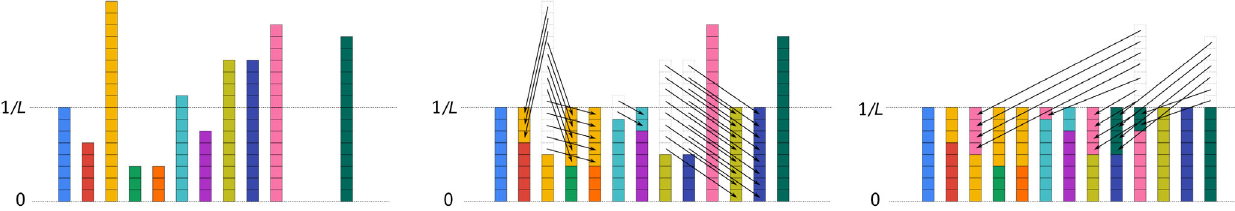
FIG. 13. Depiction of choosing alt l and keep l values for a discretized probability distribution. The left histogram is the input probability distribution, after discretization into steps of 1 = ð 2 3 L Þ . The squares must be redistributed so that every column has at most two colors and height of 1 =L (i.e., eight squares as indicated by the dashed line) without moving the bottom square of each column. The histogram on the right satisfies these constraints, and the histogram in the middle is an intermediate distribution. Arrows indicate which boxes were moved where. The color of the top square of each column in the histogram on the right determines the value of alt l , whereas keep l is determined by where the color transition is within each